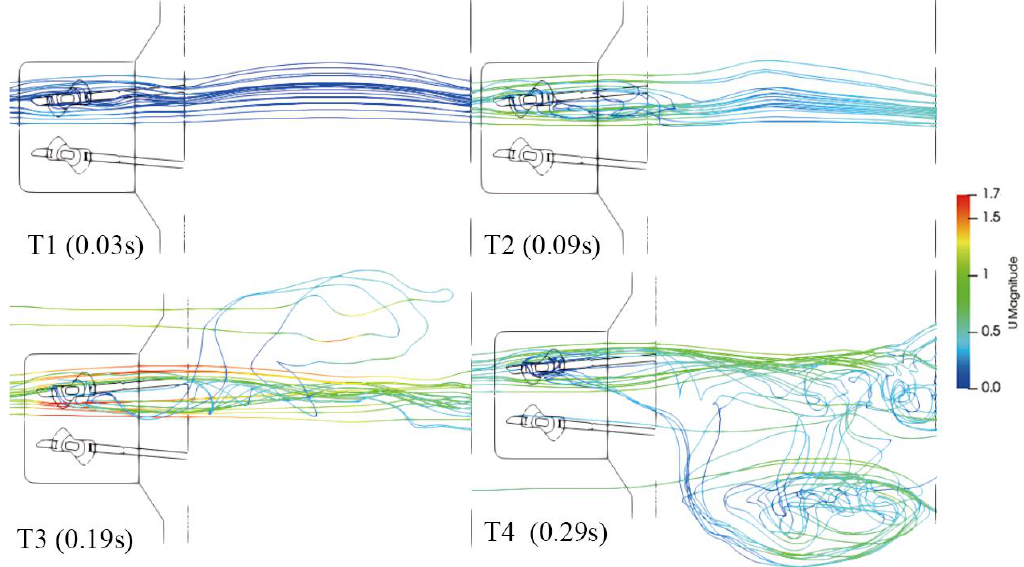
Figure 13. Velocity streamlines flowing through the hinge region (Newtonian model).